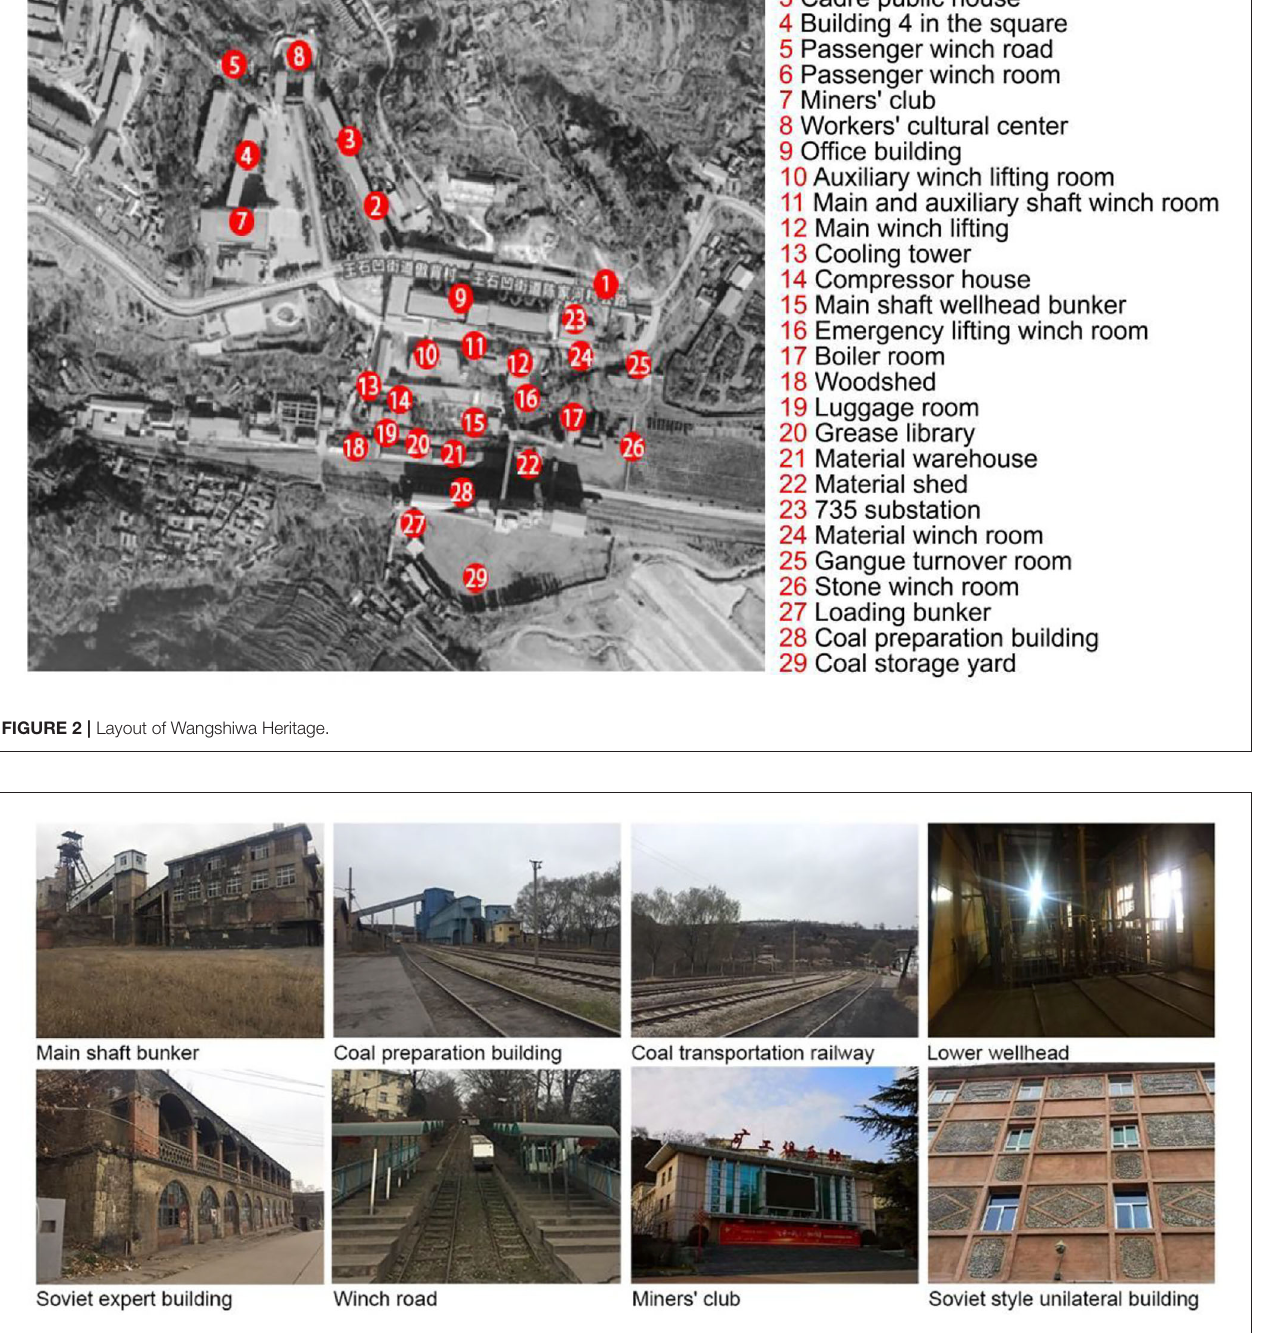
f ( n ) = g ( n ) + h ( n ) f ( n ) represents the valuation function from the starting point to the target point. g ( n ) is the movement cost from